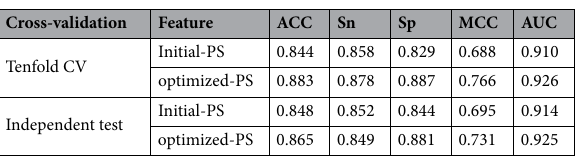
Table 4. Cross-validation and independent test results of SCM-based classifiers using initial-PS and optimized-PS.